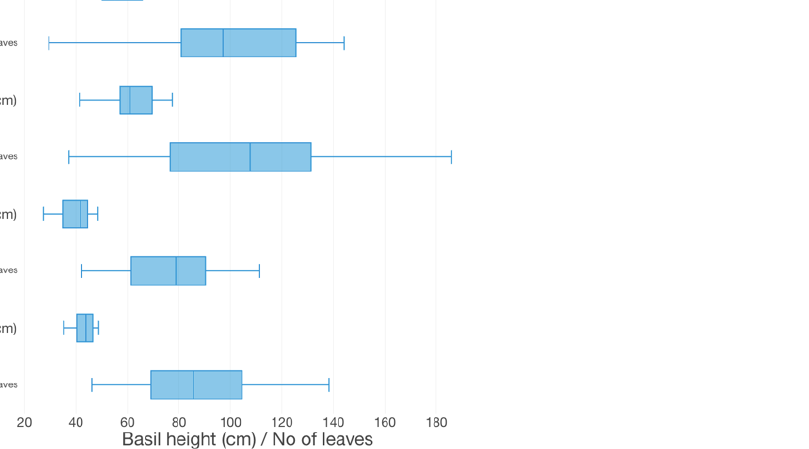
Figure 3. Boxplot for basil height and number of leaves for each experimental variant, at the end of